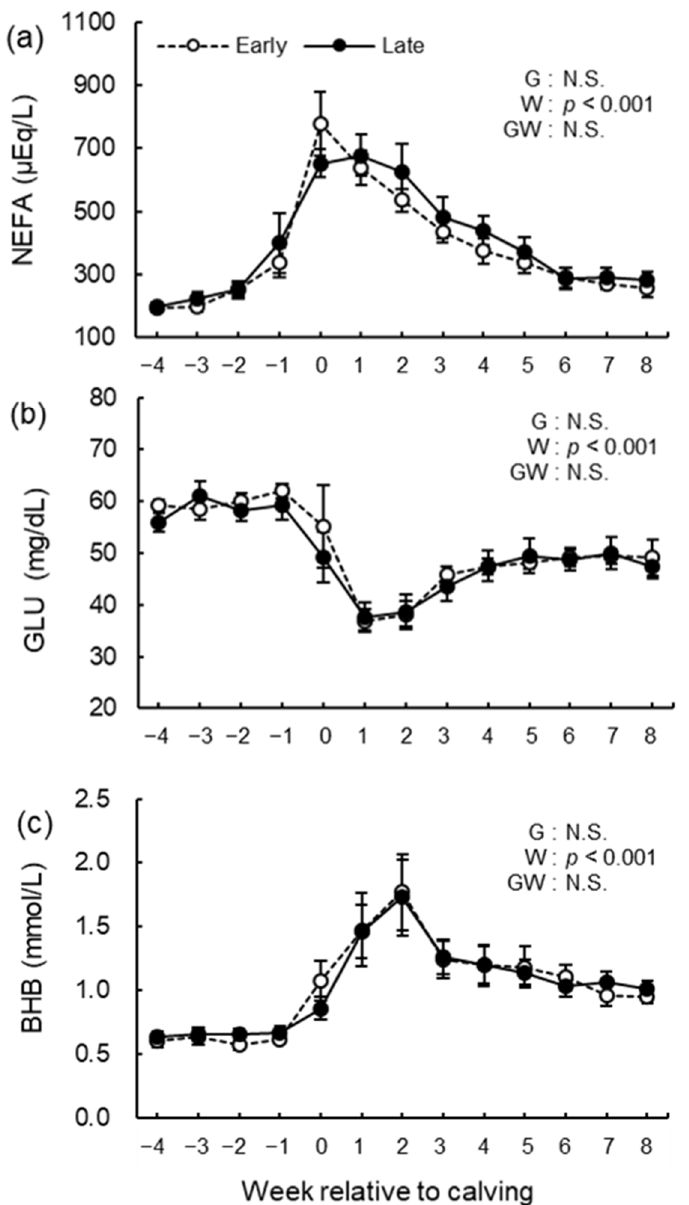
Figure 8. Serum concentrations of ( a ) non-esterified fatty acid (NEFA) and whole blood concentrations of ( b ) glucose (GLU), and ( c ) β-hydroxybutyrate (BHB) from −4 to 8 wk relative to calving for cows classified into the early group (Early) and the late group (Late). Early = cows with endometrial inflammation converged within 4 wk, n = 17; Late = cows with endometrial inflammation converged at or after 5 wk, n = 16. The week of calving is defined as 0 wk. G = group effect; W = week effect; GW = group-by-week interaction. Data are shown as mean ± SEM.